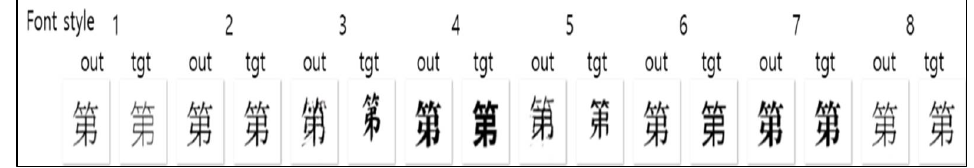
Figure 21. Failure examples (font styles 3 and 5).